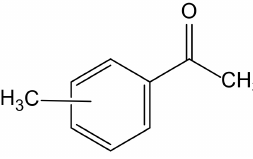
Figure 2. General structure of methylacetophenone